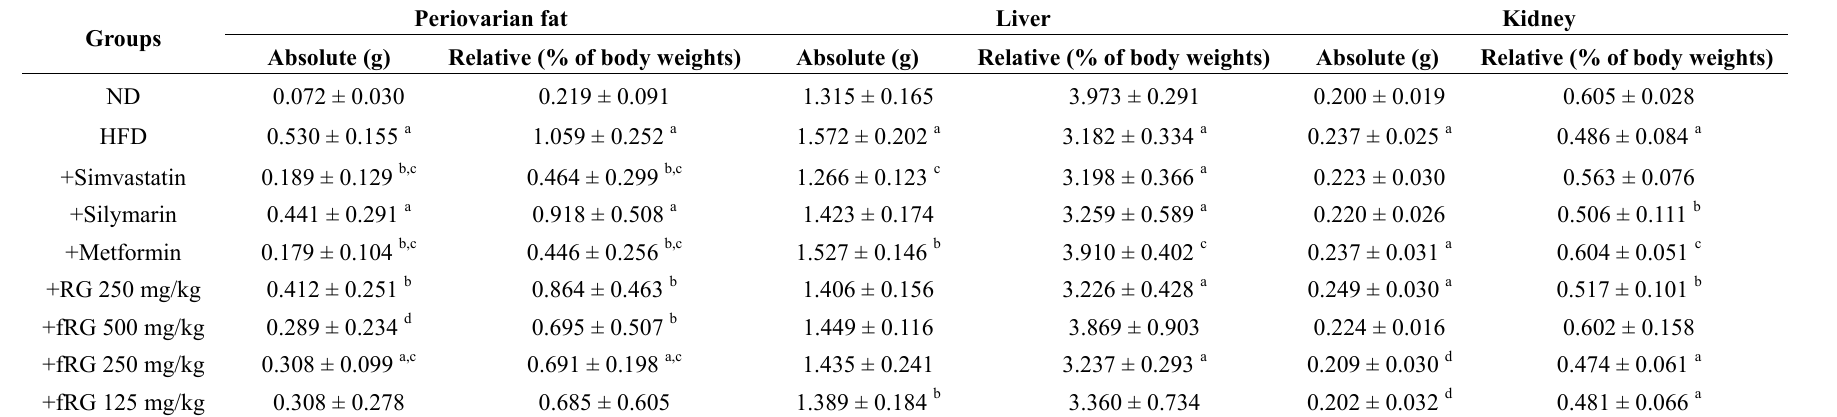
Table 2. Organ weights after 84 days of continuous oral treatment of fRG in HFD-fed mice.